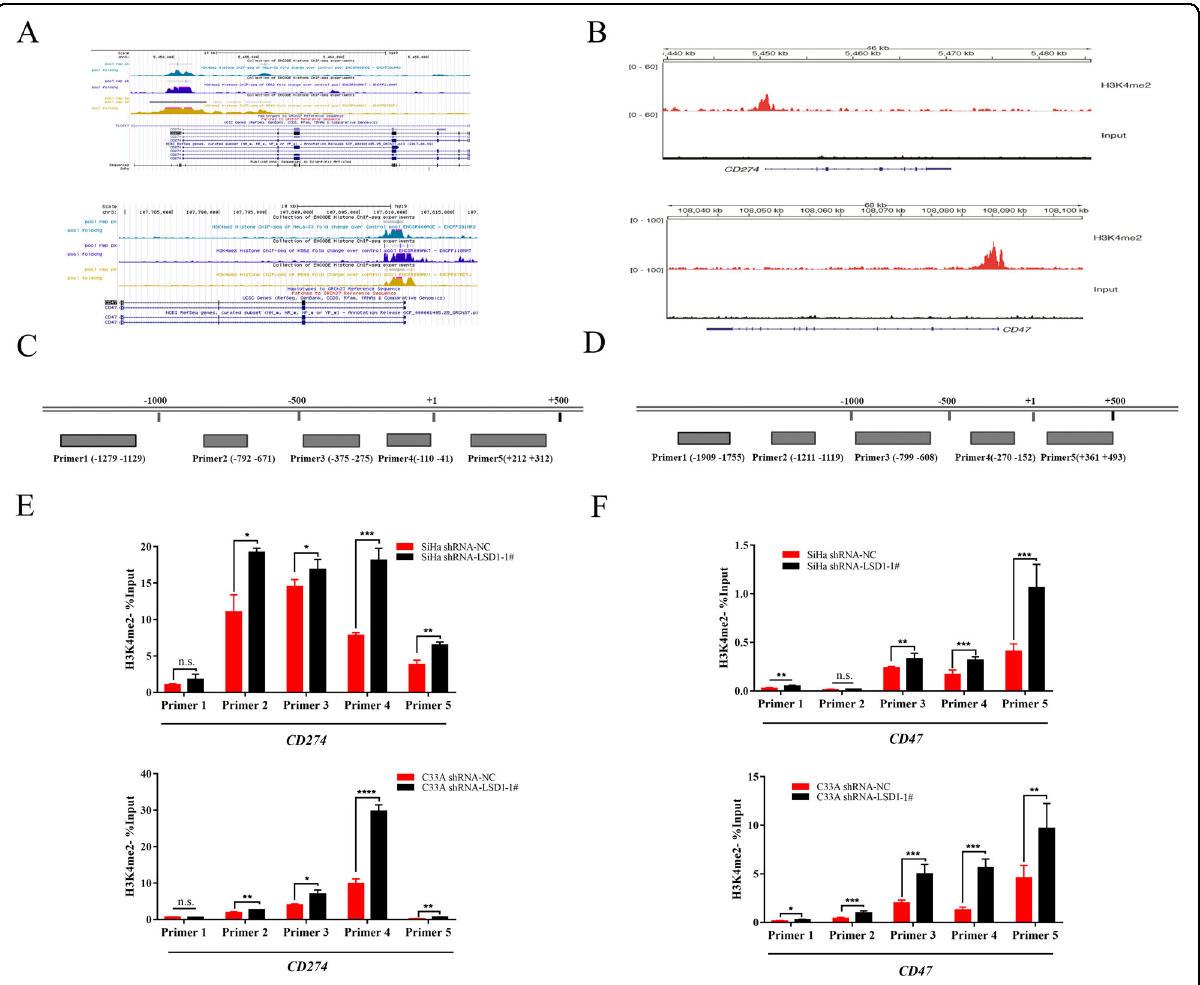
Fig. 2 LSD1-mediated H3K4 demethylation in the CD274 / CD47 promoter region. A High abundance of H3K4me2 aggregation occurred in the CD274 / CD47 promoter region in a variety of tumor cells, including cervical cancer, according to histone ChIP-Seq data from the ENCODE database. B ChIP-Seq performed for SiHa cells also con fi rmed universal enrichment of H3K4me2 marks in the CD274 / CD47 promoter region. C , D Speci fi c sequences targeting the CD274 / CD47 promoter region. E ChIP-qPCR indicated that the H3K4me2 level in the CD274 promoter region increased signi fi cantly after LSD1 knockdown in SiHa and C33A cells ( n = 3 per group); F the H3K4me2 level in the CD47 promoter region underwent the same change ( n = 3 per group). ChIP-qPCR experiments were repeated twice. N.S. not signi fi cant. * p < 0.05; ** p < 0.01; *** p < 0.001; **** p <